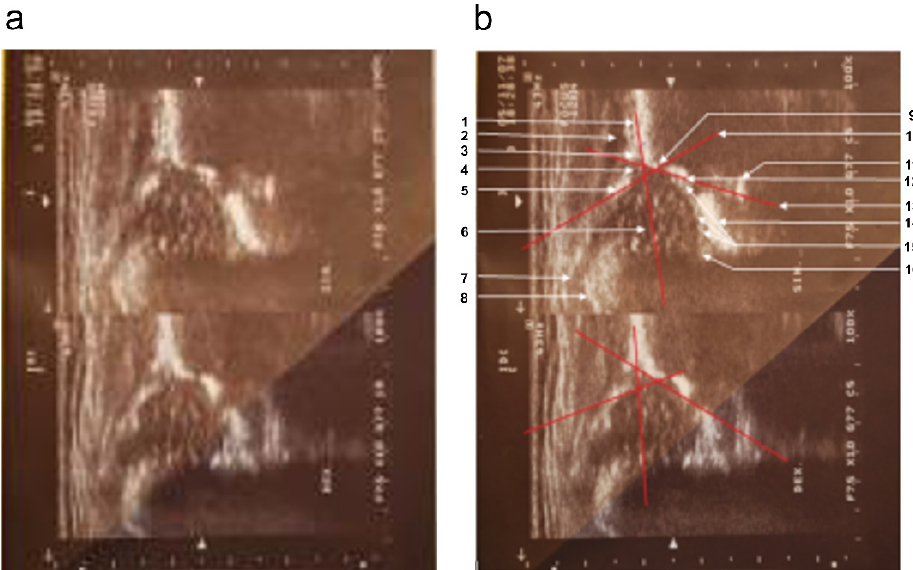
Figure 1. Sonograms of the girl’s hip joints at 5 weeks of age (first appointment). ( a ) Top (left hip joint): three basic elements are visible, i.e., the labrum, the “blunt” bone edge marking the point where the bulge of the iliac bone passes into the concavity of the acetabulum, and the lower edge of the iliac bone. The alpha angle between the bone roofline and the baseline is 65°; the beta angle between the cartilaginous roofline and the baseline is 69°. Lack of ossification nuclei (physiological norm). Type Ib according to Graf. Bottom part (right hip joint): three basic elements are visible: the labrum, the “rounded” bone edge marking the point where the protrusion of the iliac bone passes into the concavity of the acetabulum, and the lower edge of the iliac bone. The alpha angle between the bone roofline and the baseline is 56°; the beta angle between the cartilage roofline and the baseline is 74°. Lack of ossification nuclei (physiological norm). Type IIa according to Graf. ( b ) Sonograms with overlay and description of anatomically important points. Top: 1—baseline, 2—gluteus minimus muscle, 3—tendon of the femoral rectus muscle, 4—the cartilaginous roof of the acetabulum, 5—labrum, 6—cartilaginous femoral head (no ossification nucleus), 7—cartilaginous major trochanter with the turning synovial fold of the joint capsule, 8—cartilage– bone boundary, 9—bone edge (blunt type), i.e., turning point, 10—cartilage roofline, 11—internal perichondrium of the “Y” cartilage, 12—lower ilium bone edge, 13—bone roofline, 14—soft tissues at the bottom of the acetabulum, 15—round ligament of the femoral head, 16—transverse ligament. Bottom: marked baseline, cartilage roofline, and bone roofline.